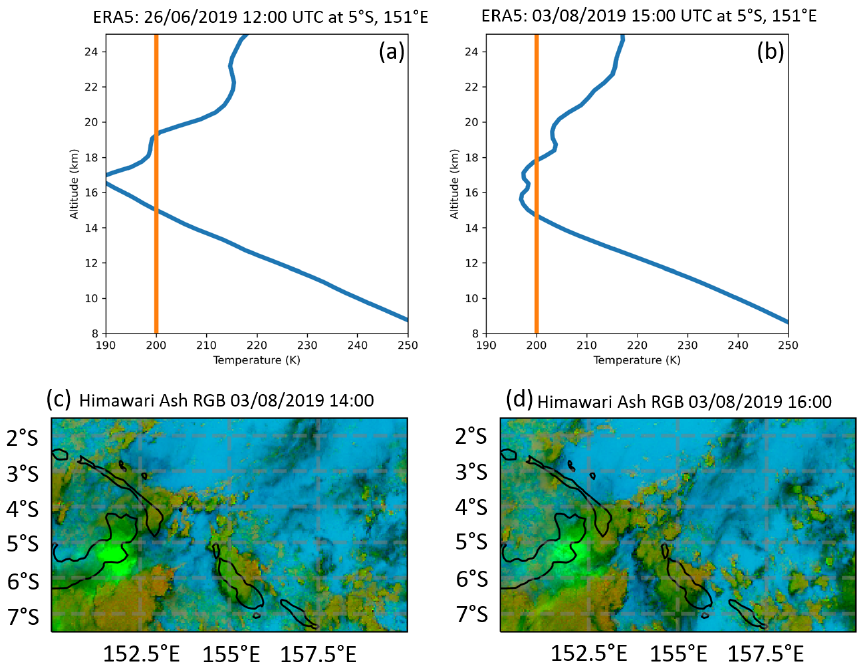
Figure A2. (a, b) As in Fig. A1 (a) but for both Ulawun eruptions accordingly. (c, d) Similar to Fig. 1, Himawari ash RGB for the second Ulawun eruption. Bright green represents SO 2 , while darker green shades show clouds.